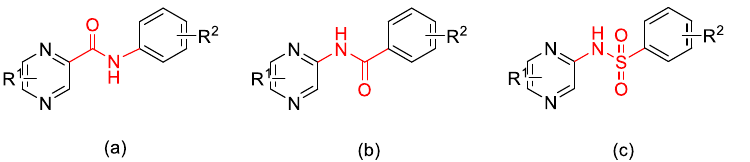
Figure 1. Design rationale: general structure of ( a ) pyrazinecarboxamides = amides; ( b ) N -pyrazinylbenzamides = retro-amides; and ( c ) title compounds = sulfonamides.